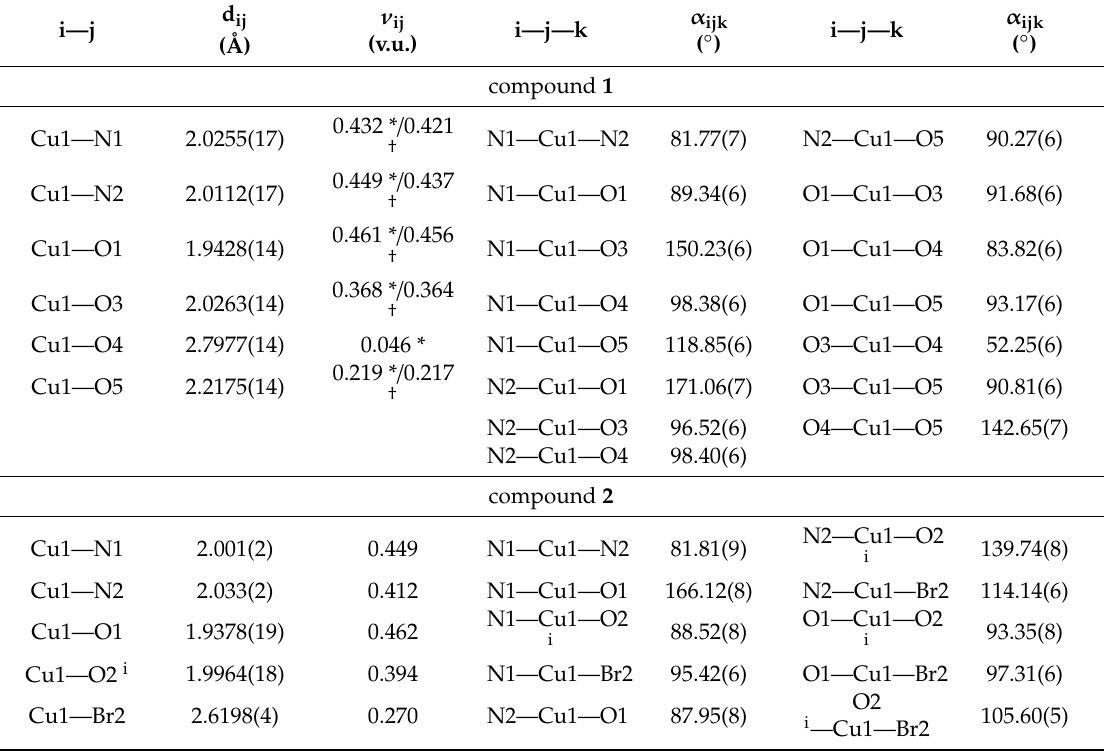
Table 1. Selected structural data of the studied